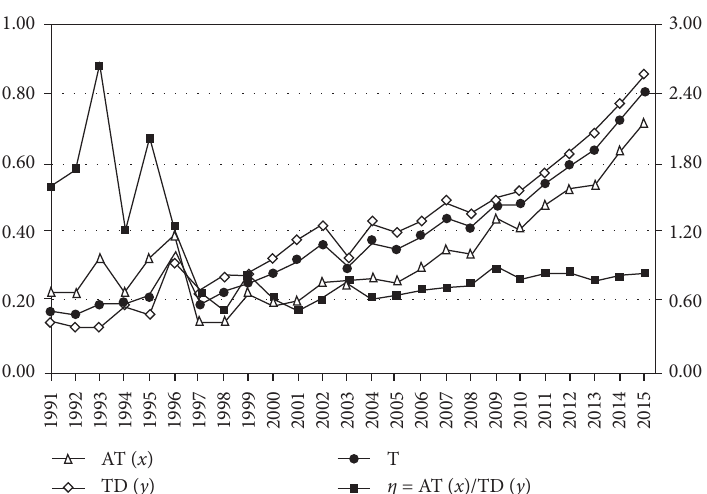
Figure 2: Changes of AT ( x ), TD ( y ), T , and η from 1991 to